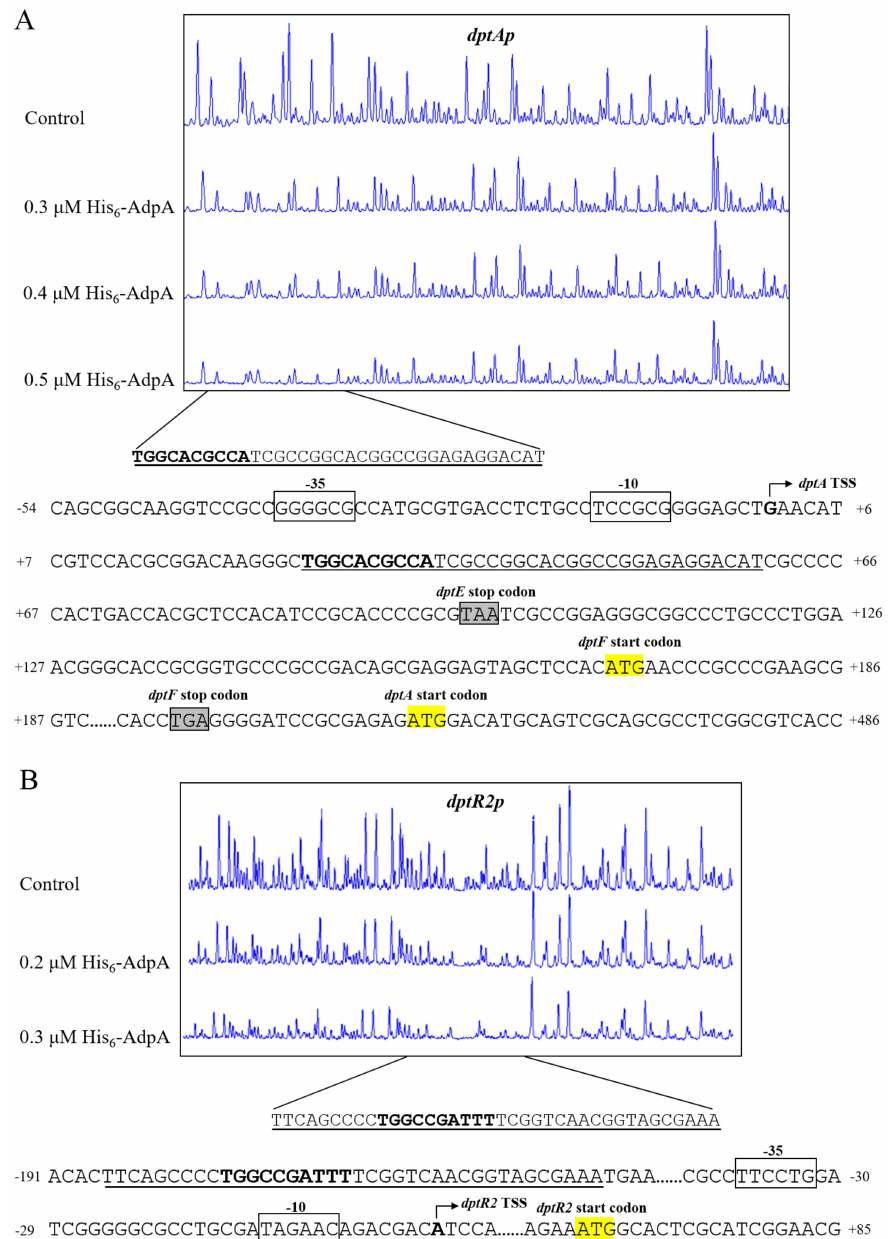
Figure 8. DNase I footprinting assays and nucleotide sequences of AdpA-binding sites on dptAp ( A ) and dptR2p ( B ). Numbers: distance (nt) from respective TSSs. Bent arrows: TSSs. Boxes: putative − 10 and − 35 regions. Yellow highlight: TSCs. Solid lines: AdpA protected regions. Bold font: sequence similar to the consensus AdpA-binding